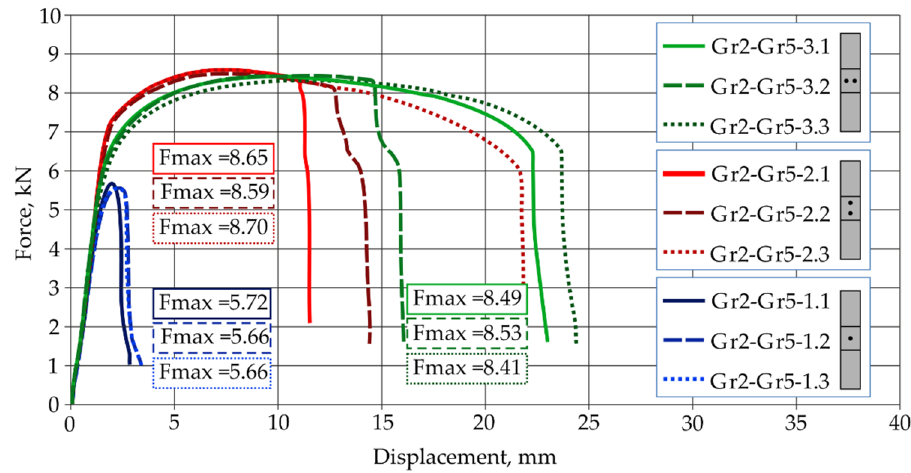
Figure 4. Force-displacement diagram from tensile shear test of Grade2–Grade 5 joints.